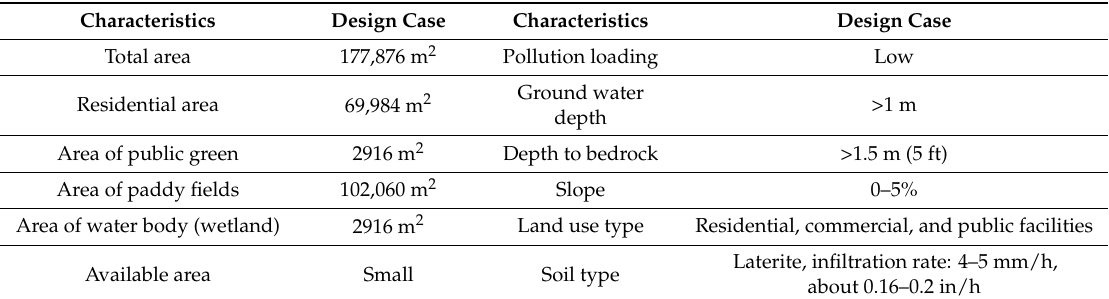
Table 2. Characteristics for the design